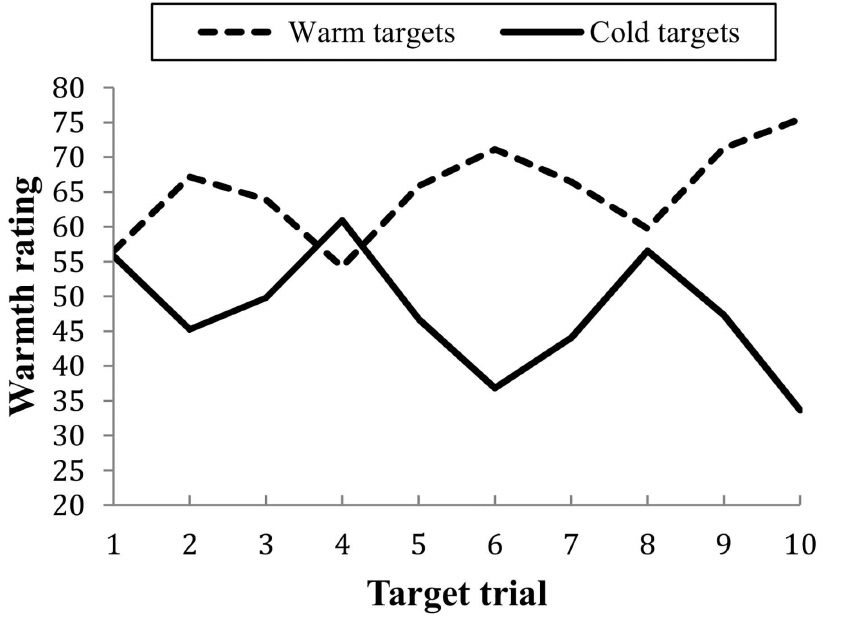
Fig 1. Warmth ratings across the 10 trials for mainly warm and mainly cold